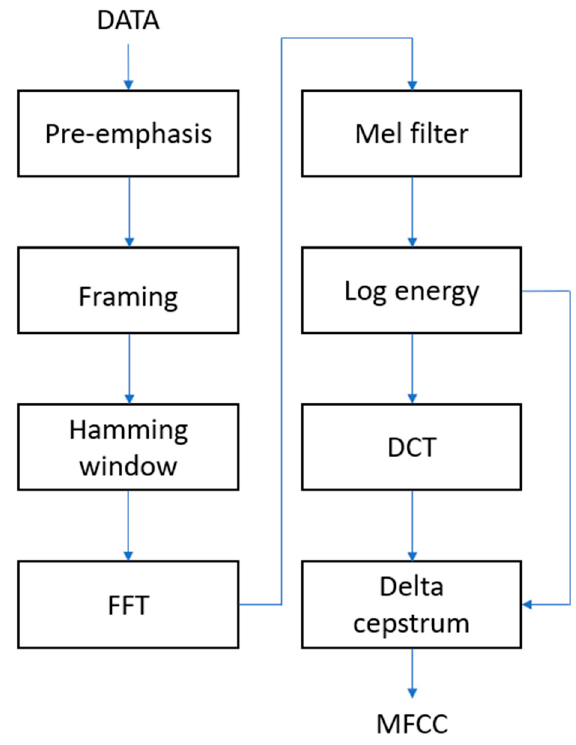
Figure 4. Flow chart of